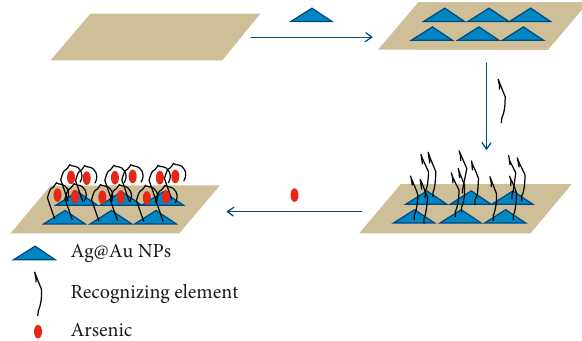
Figure 5: Mechanism flow chart of the preparation of the Ag@Au core-shell NP chip and its application in analysis.